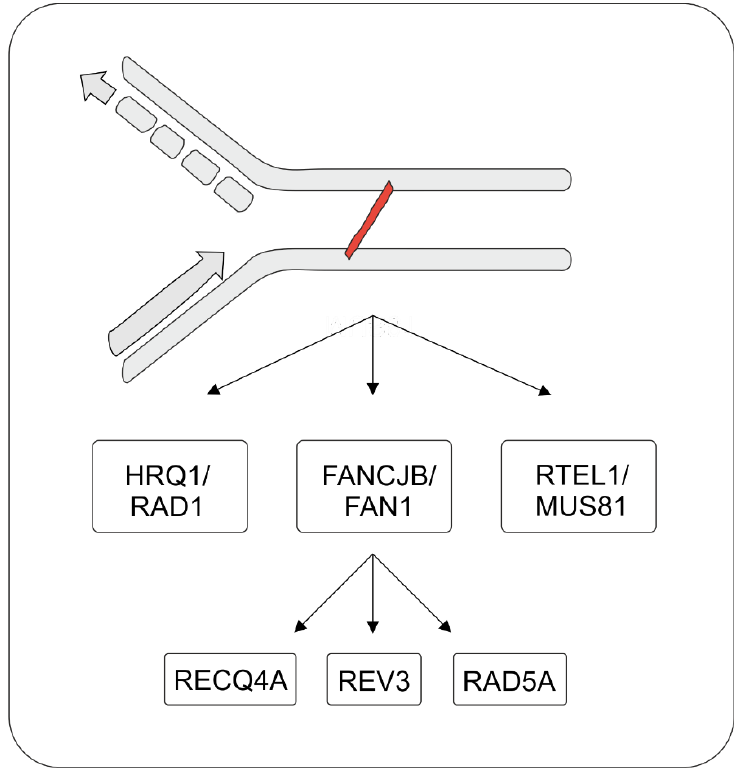
Figure 4. Model for the ICL repair network in Arabidopsis thaliana . The initiation of ICL repair is based on the activity of helicases and nucleases, which define three independent pathways. The helicase FANCJB acts together with the nuclease FAN1 in ICL repair. After initial processing, the repair is completed via RECQ4A, REV3 or RAD5A. A second parallel pathway is defined by the helicase HRQ1 in combination with the endonuclease RAD1, while the third pathway is dependent on the helicase RTEL1 and the endonuclease MUS81.